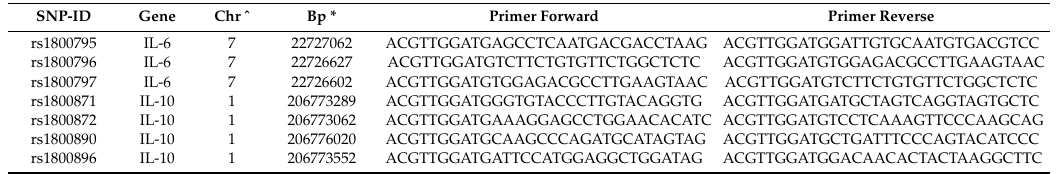
Table 2. The single nucleotide polymorphisms (SNPs), SNP positions, and primers sequences for IL-6 and IL-10